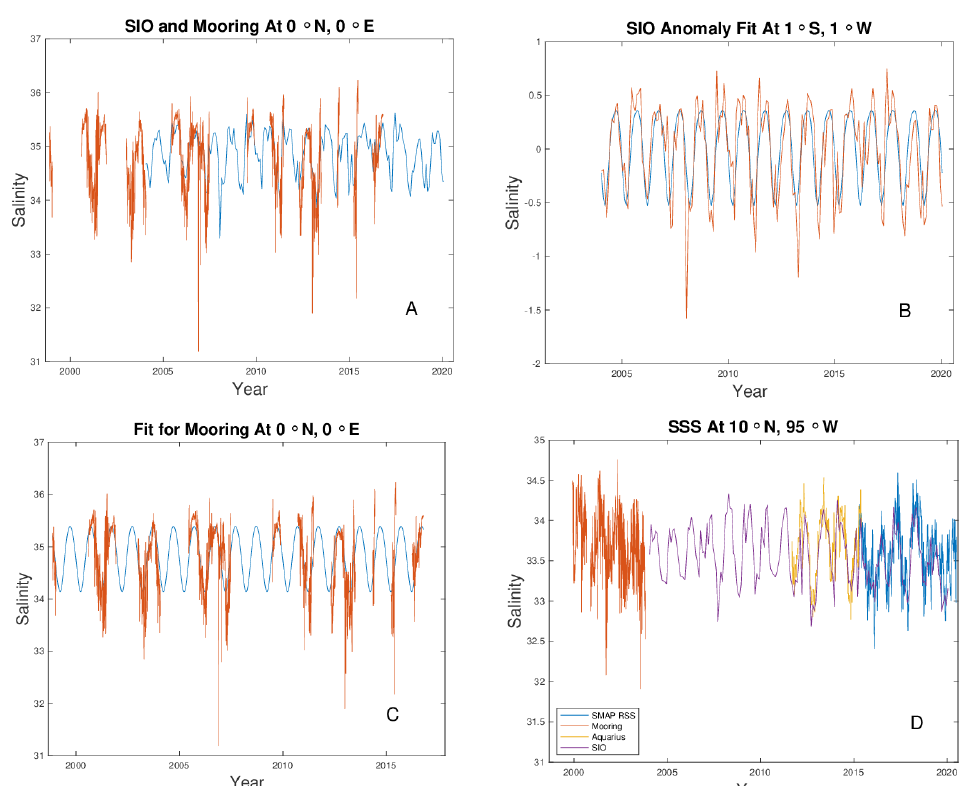
Figure 2. Harmonic fits and observations of sea surface salinity (SSS) at (0°N, 0°E). (a) Mooring (red) and SIO (blue) observations. (b) SIO anomaly (red) and its harmonic fit (blue). (c) Mooring (red) and its harmonic fit (blue). (d) SSS data from 10°N, 95°W. Source of data is indicated in the legend at the bottom left.